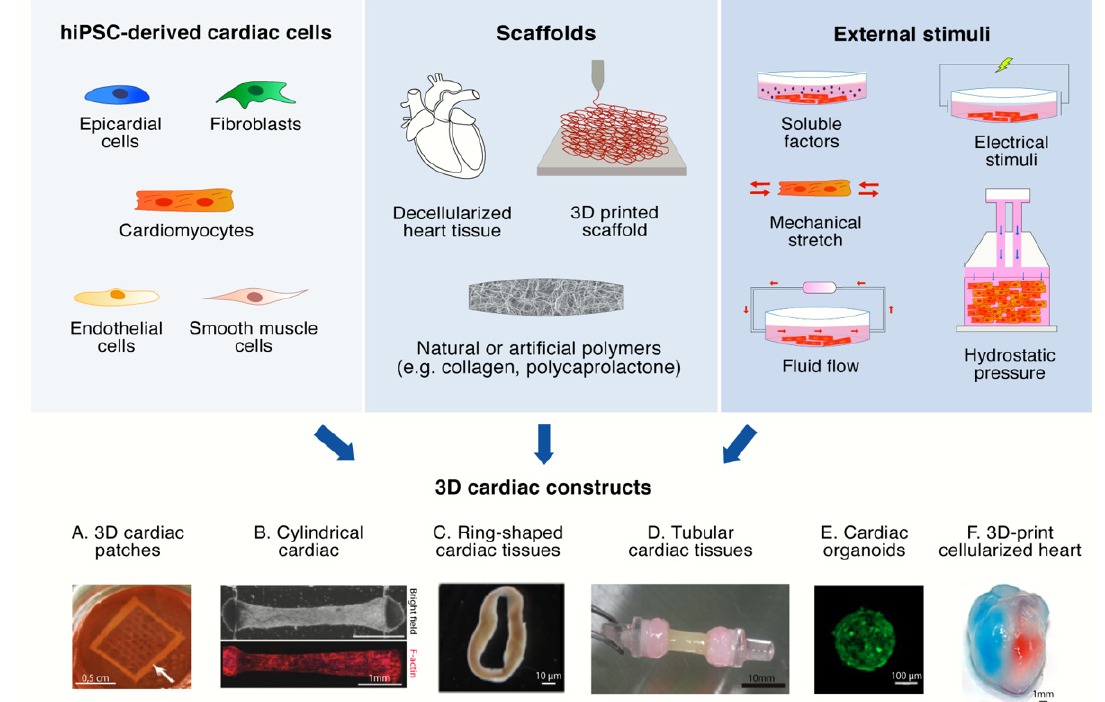
Figure 2. Generation of three-dimensional (3D) hiPSC-based cardiac constructs. Human iPSC-derived cardiac cells, sca ff olds, and physical and environmental stimuli are the three main elements required for the generation of a 3D cardiac construct. Examples of 3D-hiPSC formats are reported from published studies. Figures reprinted from: (A) [93] Zhang et al., Tissue-engineered Cardiac Patch For Advanced Functional Maturation Of Human ESC-derived Cardiomyocytes, Biomaterials 34(23), 5813-20 (2013). With permission from Elsevier (Copyright 2013, Elsevier LTD.); (B) [111] Zhao et al., A Platform